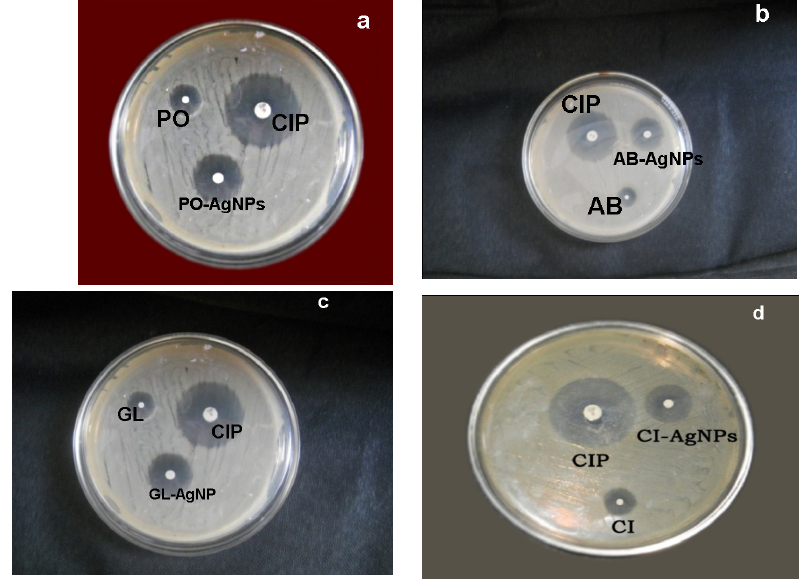
Fig. 4. Antimicrobial activity of silver nanoparticles against S. aureus (gram